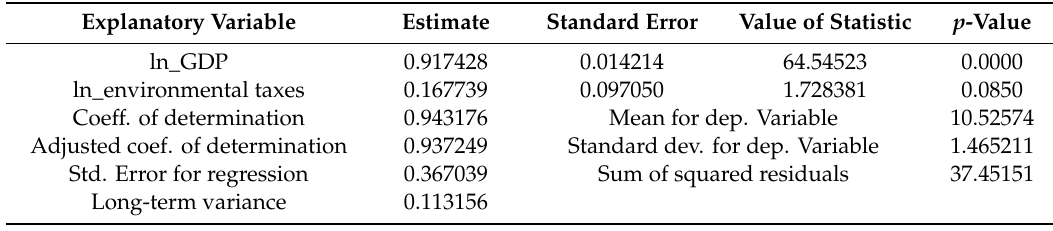
Table 7. Panel data model based on FMOLS estimators to explain changes in energy consumption from non-renewable sources (RESs) in the EU countries and UK (2007–2019).